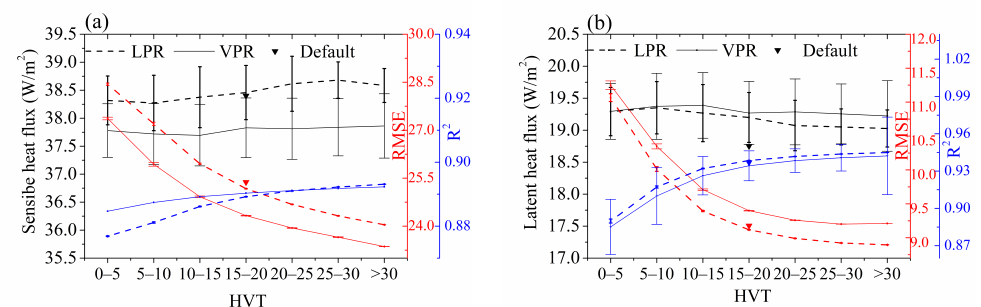
Figure 8. Accuracy assessment of energy simulations under different scenarios. ( a ) Sensible heat flux and ( b ) latent heat flux. Black lines represent values, red lines indicate RMSE, and blue lines refer to R 2 . Vertical bars represent the standard deviations of the